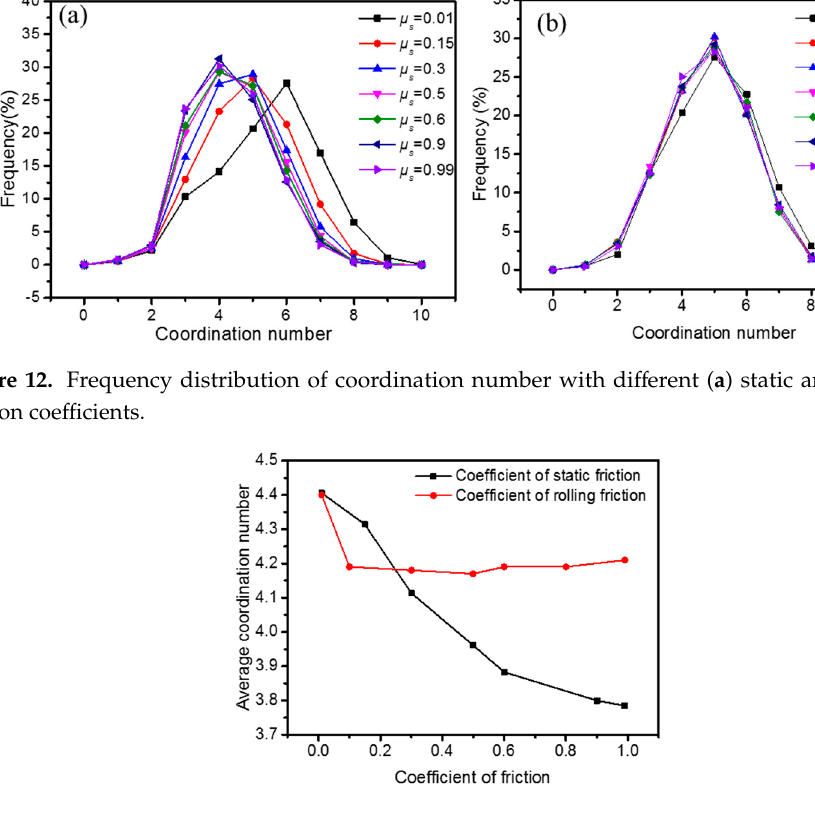
Figure 13. The average coordination number of the whole heap for different static ( 𝜇 (cid:3045) = 0.12 ) and rolling friction ( 𝜇 (cid:3046) = 0.15 ) coefficients.